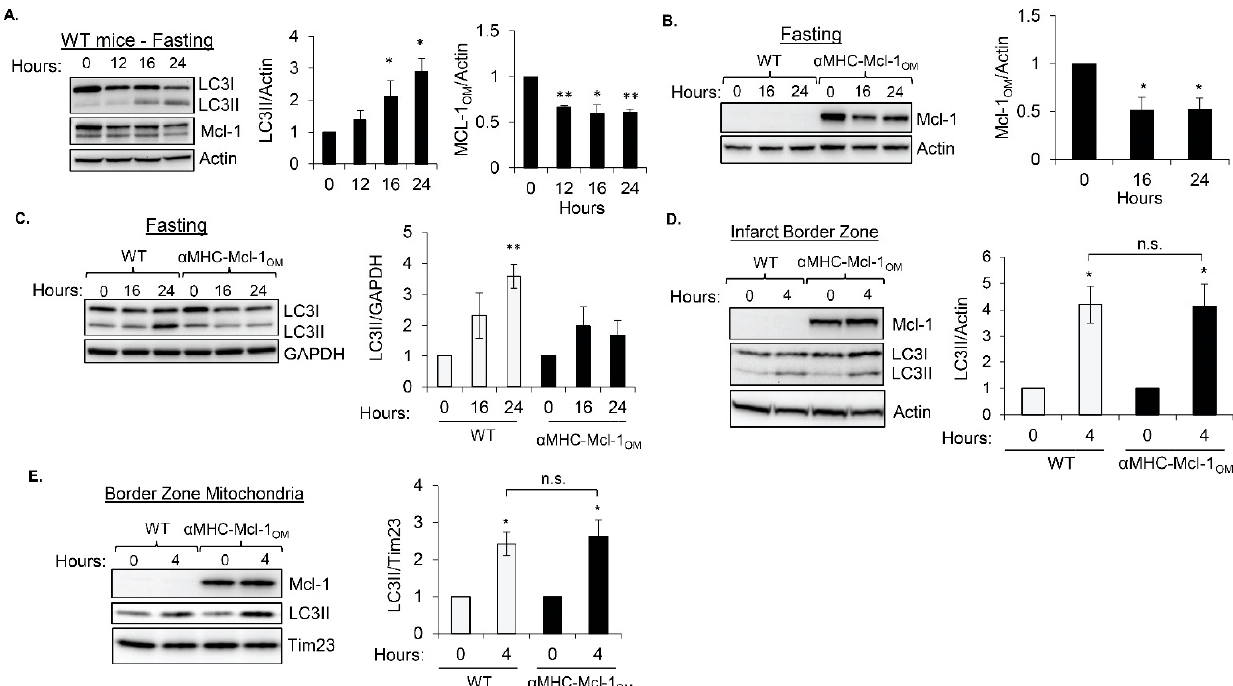
Figure 2. Overexpression of Mcl-1 OM prevents induction of autophagy in hearts during fasting but not in response to myocardial infarction. ( A ) Representative Western blot and quantification of endogenous Mcl-1 and LC3II protein levels in the hearts of wild-type (WT) mice after 0, 12, 16, and 24 h of fasting ( n = 3). ( B ) Representative Western blot and quantification of Mcl-1 OM transgene levels in hearts after 0, 16, and 24 h of fasting ( n = 4). ( C ) Representative Western blot and quantification of LC3II levels in hearts of WT and α MHC- Mcl-1 OM mice after 0, 16, and 24 h of fasting ( n = 4). ( D ) Representative Western blot and quantification of LC3II protein levels in the infarct border zone 4 h postmyocardial infarction ( n = 5). ( E ) Representative Western blot and quantification of LC3II protein levels in mitochondrial fractions isolated from the infarct border zone of hearts in WT and α MHC- Mcl-1 OM mice at 4 h after myocardial infarction ( n = 5). * p < 0.05 and ** p < 0.01 compared to 0 h control, n.s., not significant. Data are mean ± SEM. Statistical test: ANOVA, followed by Dunnett’s or Bonferroni’s multiple comparison